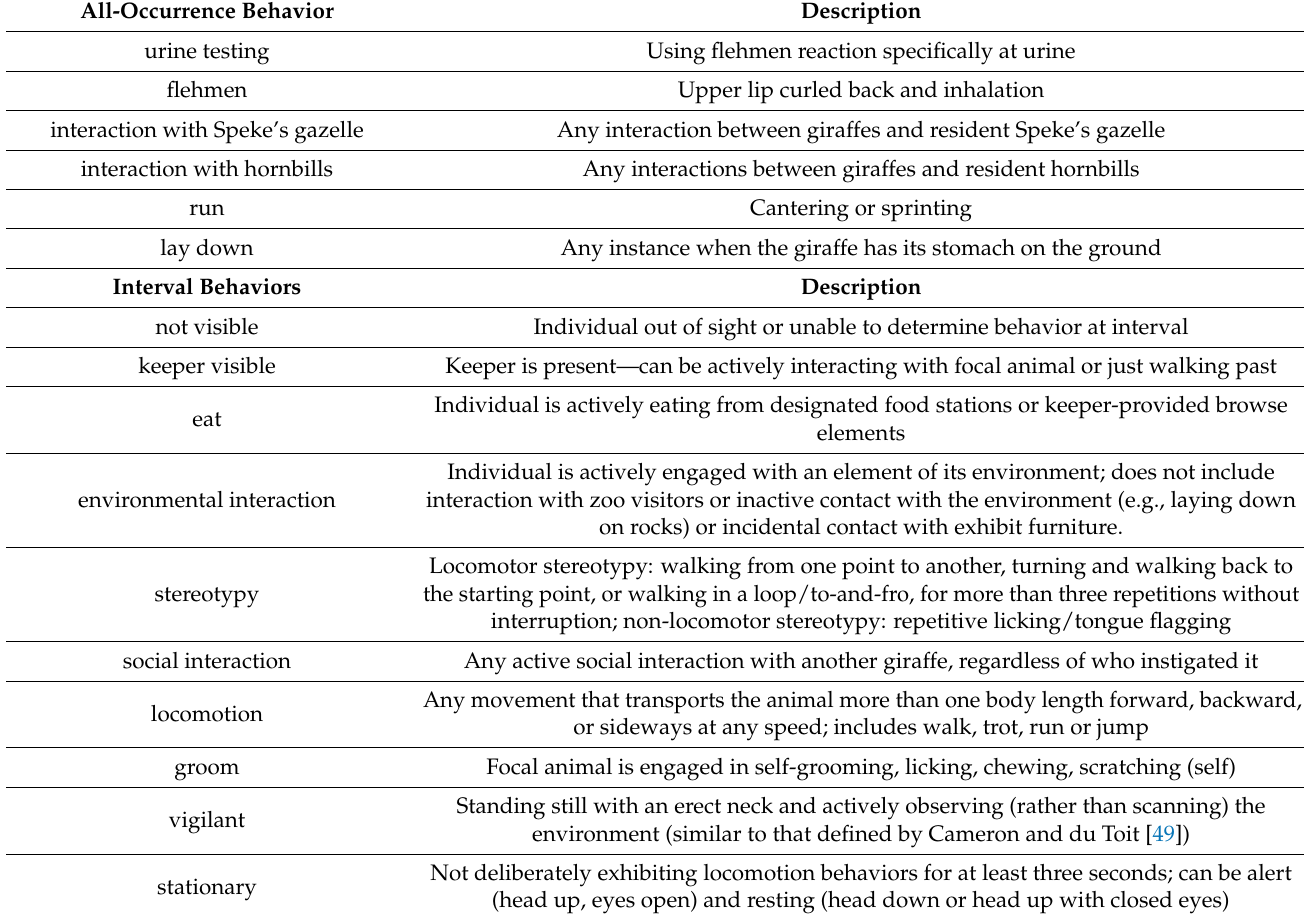
Table 3. Pre-established giraffe ethogram [47].